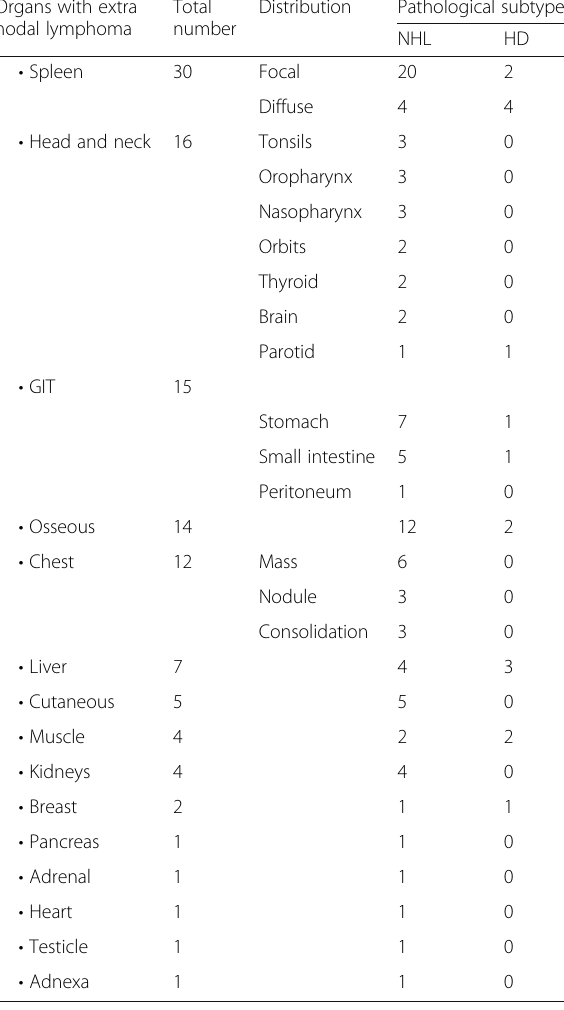
Table 1 The organs with extranodal lymphoma and related pathological subtypes in the study group Organs with extra nodal lymphoma